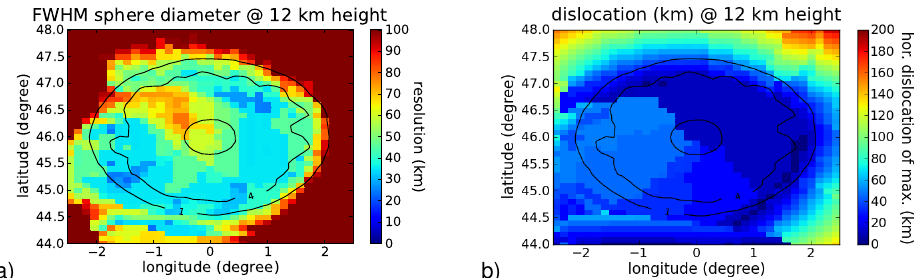
Fig. 19. The resolution of the retrieval run with advection and an averaged a priori knowledge. The left panel (a) shows the FWHM sphere diameter. Panel (b) shows the distance between the shown data element and the element with the largest contribution in the associated row of the averaging kernel matrix. The number of tangent points within the depicted volume elements is overlaid as a contour plot.